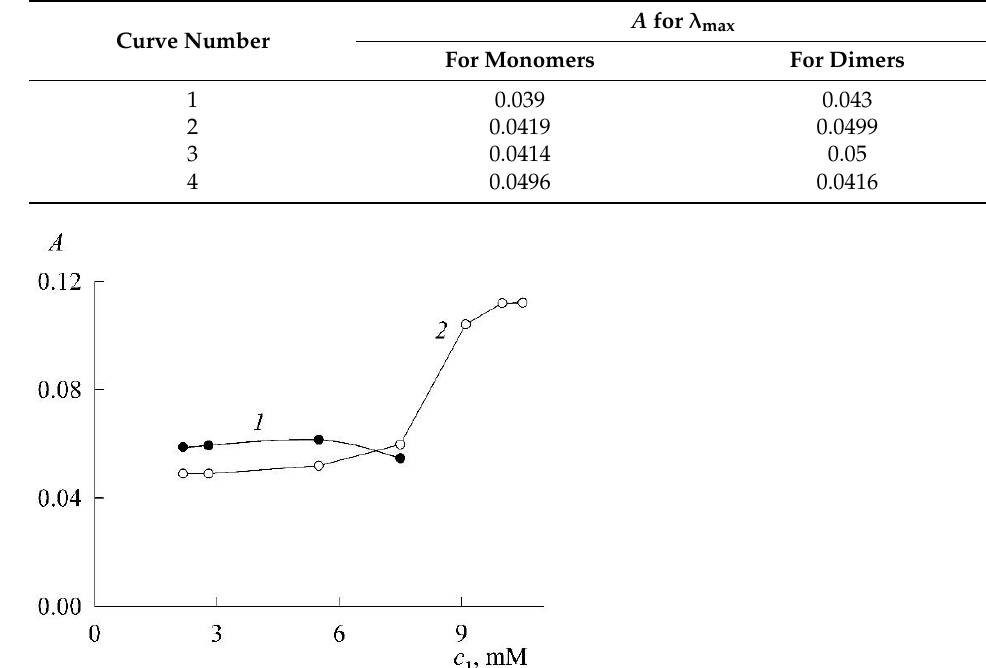
components of NR in the premicellar region of SDS solutions.